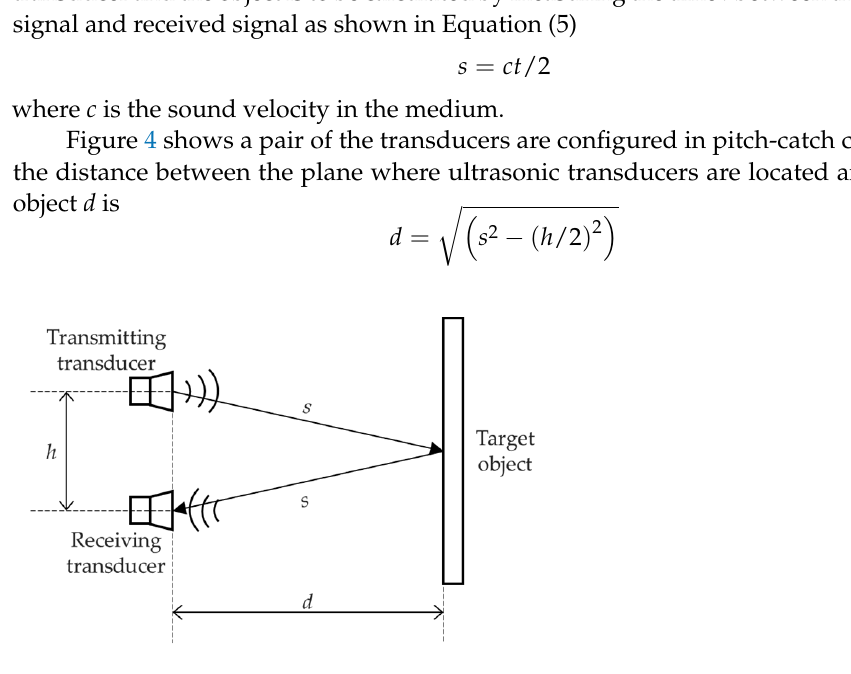
Figure 4. Schematic diagram of Ultrasonic Ranging with a pair of transducers.